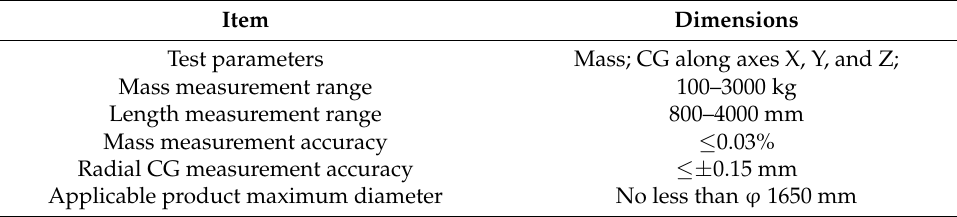
Table 1. Specification and design requirements of the systems. Item